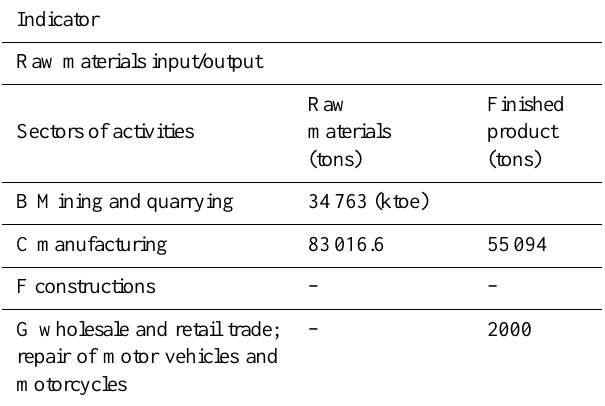
Table 4. Flows of raw materials and finished product per sector of activity.